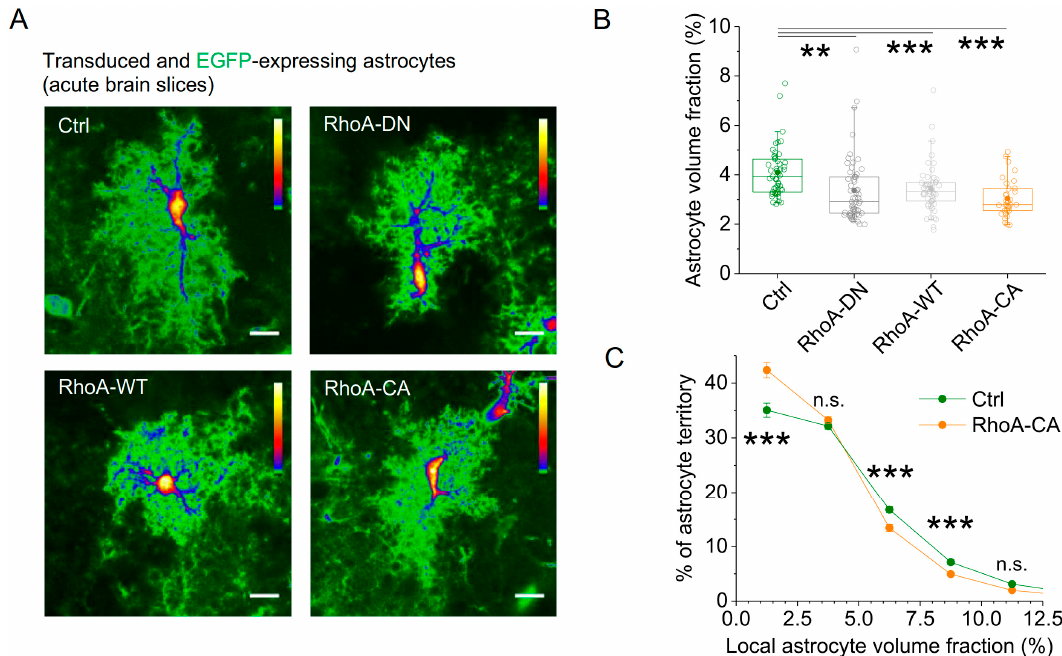
Figure 4. Increasing astrocytic RhoA activity in vivo reduces the amount of fine astrocytic pro- cesses. For testing the effect on astrocyte morphology, the four rAAVs were injected into dorsal hippocampi of mice in which astrocytes sparsely express EGFP. Astrocyte morphology was investi- gated in acute slices obtained from these mice by visualizing transduced EGFP-expressing astrocytes using 2PE fluorescence microscopy. ( A ) Sample images (tdTomato signal not illustrated, scale bar 10 μ m). ( B ) The volume fraction (VF) of the astrocyte excluding the soma and major branches was used to quantify the effect of RhoA variants on astrocyte morphology. Expression of all RhoA variants significantly reduced the astrocyte VF (Kruskal–Wallis test, p < 0.001; Dunn post hoc tests, p < 0.01, < 0.001 and < 0.001 for RhoA-DN, RhoA-WT, and RhoA-CA, respectively, ** for p < 0.01 and *** for p < 0.001). ( C ) For analysing the subcellular effects of RhoA expression, individual astrocytes were divided into evenly spaced regions of interest (see Materials and Methods), and the distribu- tion of subcellular volume fractions was determined for each cell. Average distributions are calcu- lated and displayed for RhoA-CA and control rAAVs. They reveal a shift towards lower local vol- ume fractions when astrocytes express RhoA-CA (two-way repeated measures ANOVA, p < 0.001 for Ctrl vs. RhoA-CA; post hoc Tukey test *** for p < 0.001 and n.s. for p > 0.90; p > 0.90 for local volume fractions > 12.5%). For ( B , C ), slices were analysed from at least 3 animals per condition (n = 51, 57, 51, and 33 cells for Ctrl, RhoA-DN, RhoA-WT, and RhoA-CA, respectively). SO, SP, SR rep- resent stratum oriens , stratum pyramidale , stratum radiatum , respectively. Box and Whisker plots: box indicates the 25th and 75th percentiles, whiskers the 5th and 95th percentiles, the horizontal line in the box the median, the filled circle the mean, and hollow circles the individual data points.